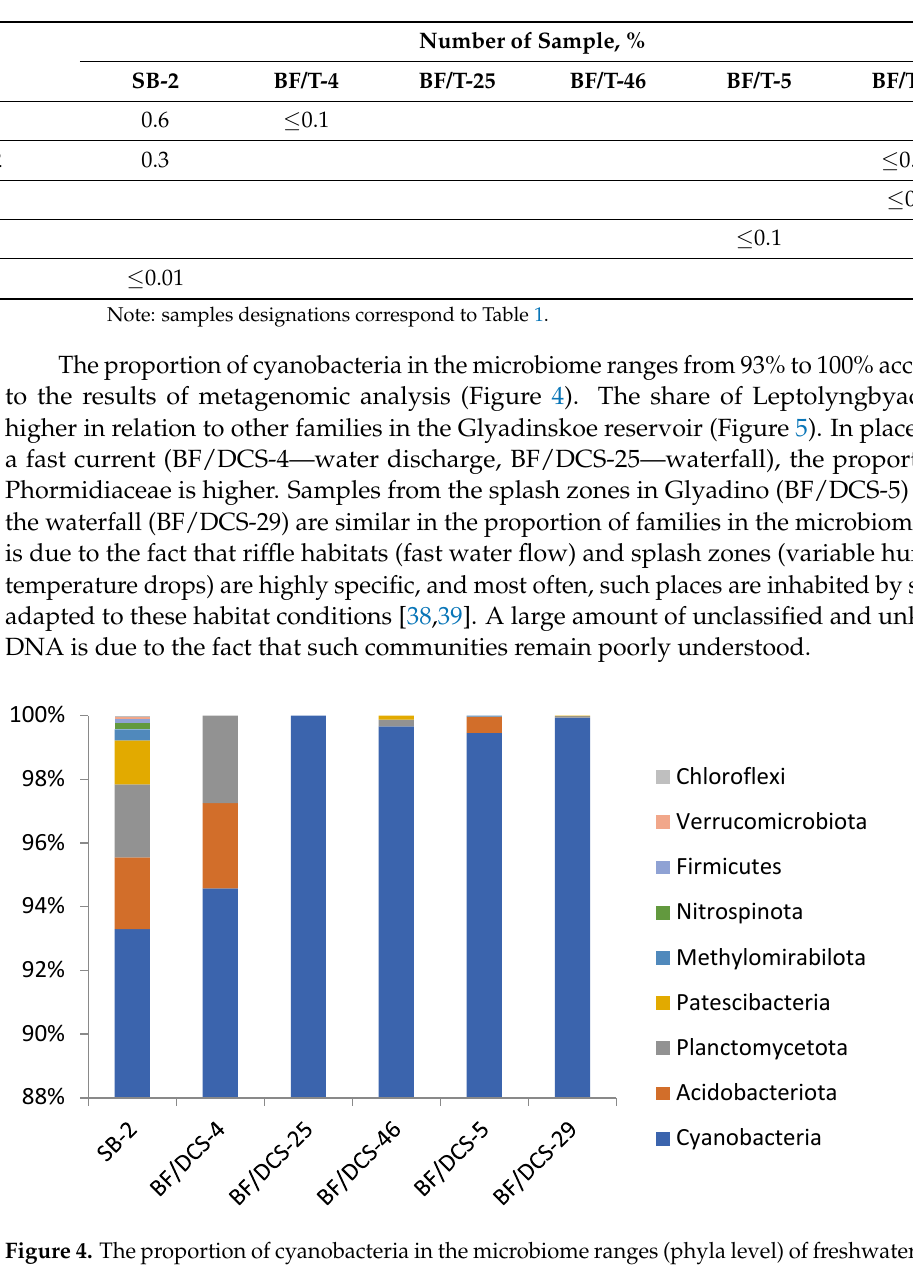
Figure 5. Representation of bacterial families (more than 1% in the microbiome) in the studied hab- itats (%, samples designations correspond to Table 1).